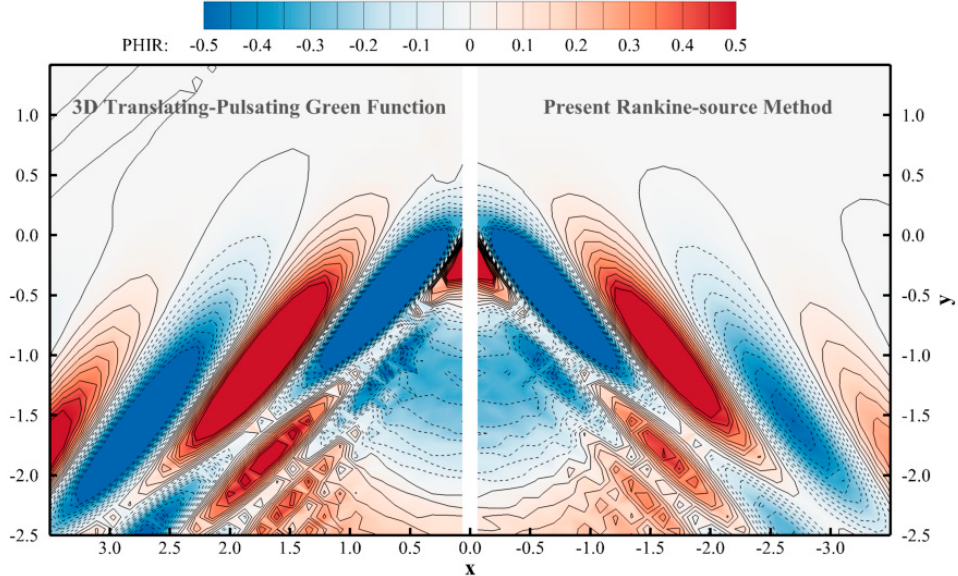
Figure 10. R [ ϕ ] by Green function and Rankine source methods at κ L = 3.0, F r = 0.2, τ = 0.347 and with Rayleigh damping μ c = 0.6 [39].